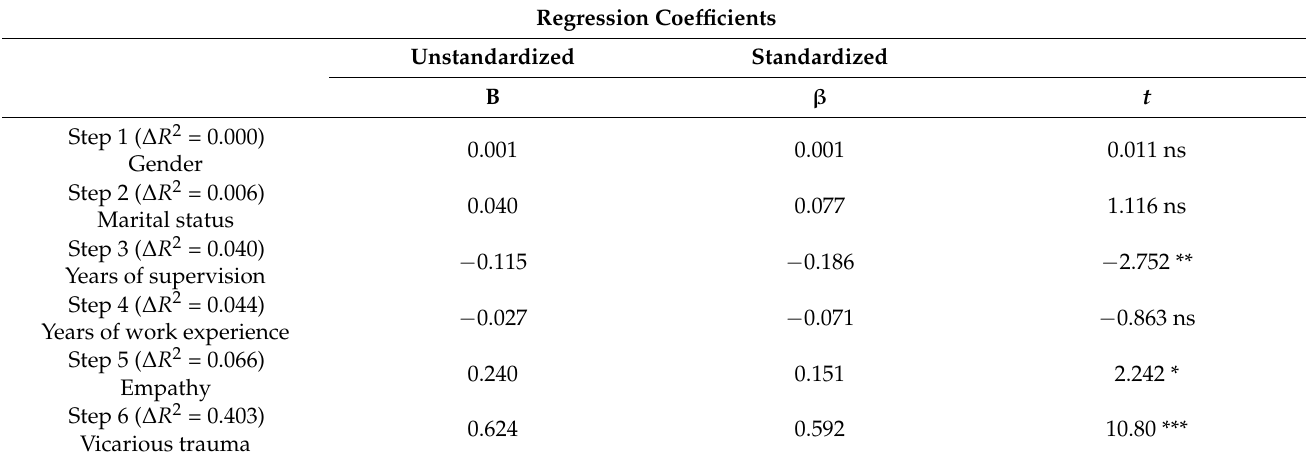
Table 3. Prediction of burnout by demographic and psychological